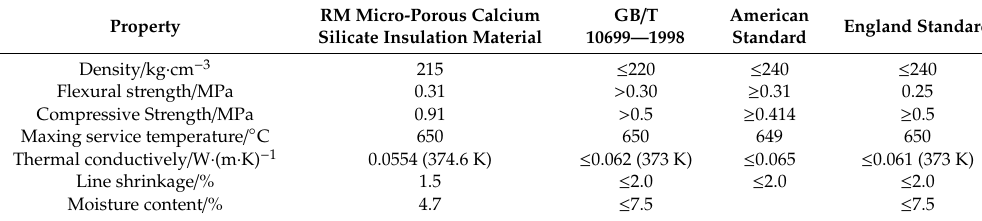
Figure 8. Production process of RM micro-porous calcium silicate thermal insulation material [91]. Table 5. Properties of RM micro-porous calcium silicate thermal insulation material [91].